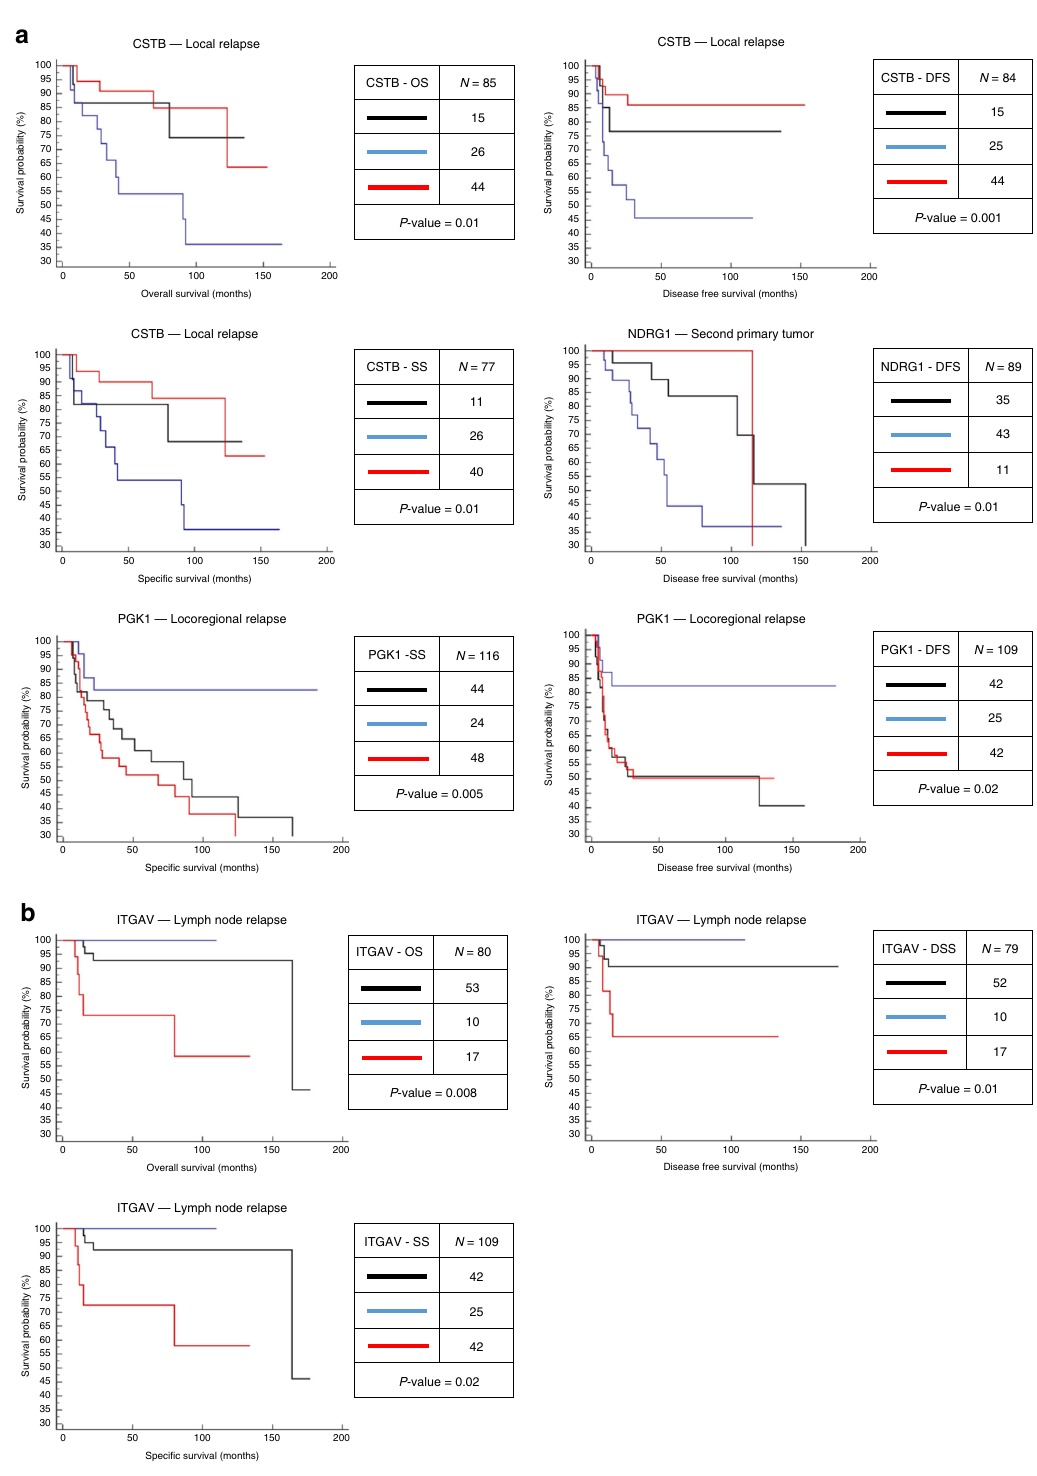
Fig. 5 Kaplan − Meier survival analysis of IHC and clinical outcomes. Overall survival (OS), disease-free survival (DFS) and speci fi c survival (SS) were available in relation to a second primary tumor, local, locoregional or lymph node relapse. a Patients with lower CSTB expression in the ITF had a higher risk of local relapse and worse survival ( P value < 0.05, log-rank test). In addition, a lower NDRG1 expression in the ITF was associated with a higher risk of the patient presenting a second primary tumor and a worse DFS ( P value < 0.05, log-rank test). Equal expression between the ITF and the inner tumor or higher CSTB and NDRG1 expression in the ITF did not in fl uence the local relapse or second primary tumor. Patients with higher PGK1 expression in the ITF had a worse survival and early locoregional recurrence ( P value < 0.05, log-rank test). b Patients with higher expression of ITGAV in the ITF have a greater risk to present lymph node metastasis relapse and poor survival ( P value < 0.05, log-rank